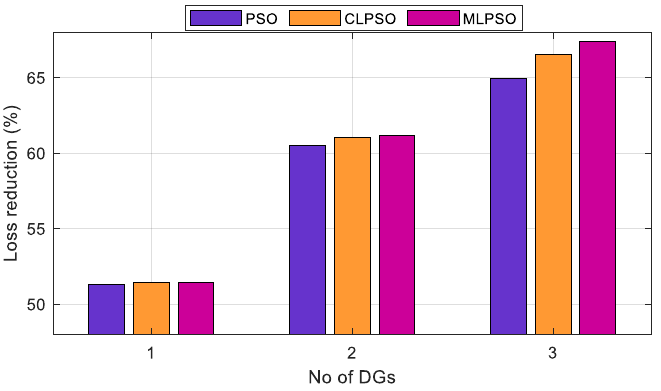
Figure 6. Variation of loss reduction with number of DGs for the IEEE 33 bus system.